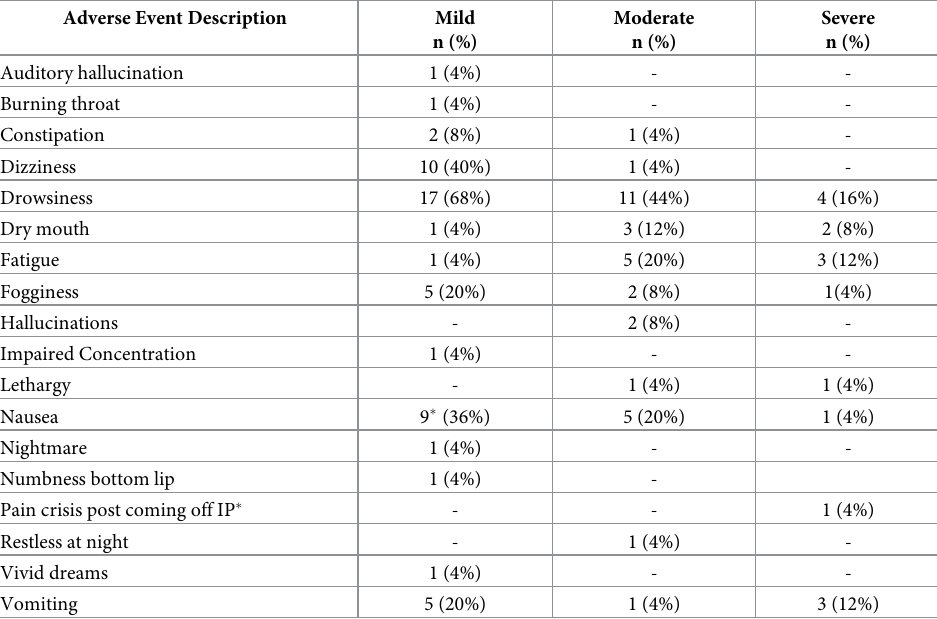
Table 5. Treatment emergent adverse events affecting one or more participants during the MAD Stage II of the pilot trial (n = 25). Adverse Event Description Mild n (%)